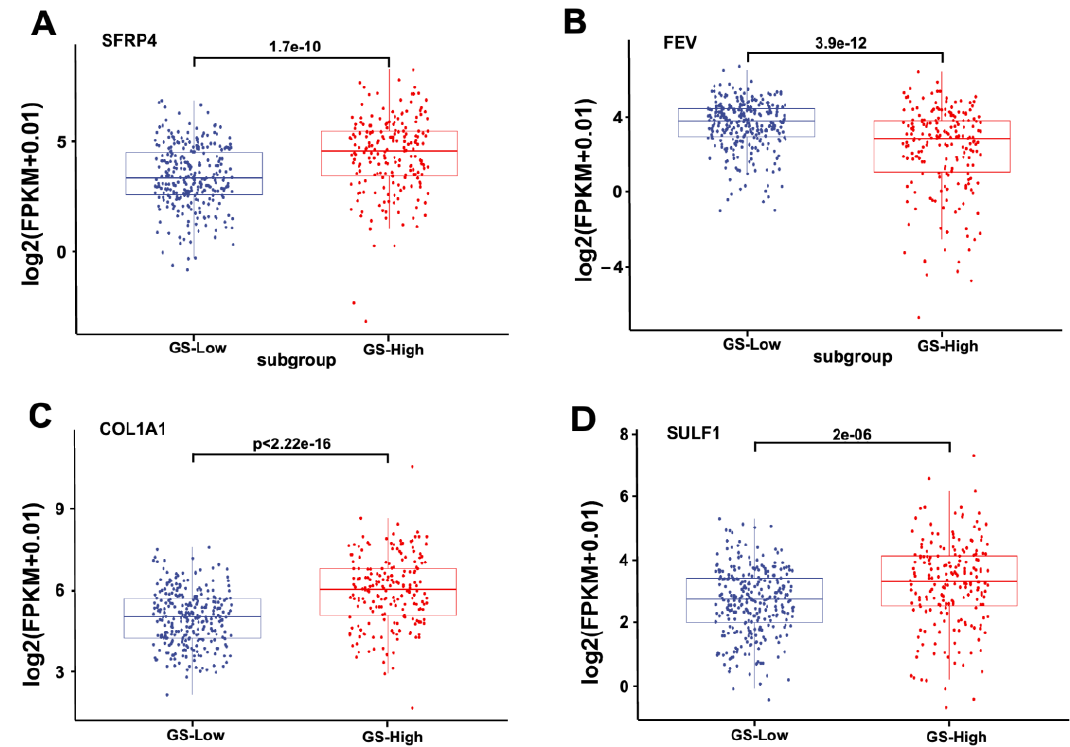
Figure 4. The expression of four genes in high-GS and low-GS groups. The expression of SFRP4 ( A ), FEV ( B ), COL1A1 ( C ), and SULF1 ( D ) in PCa patients with high GS and low GS.